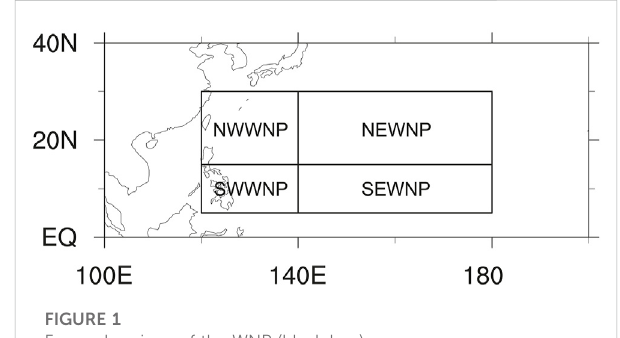
FIGURE 1 Four subregions of the WNP (black